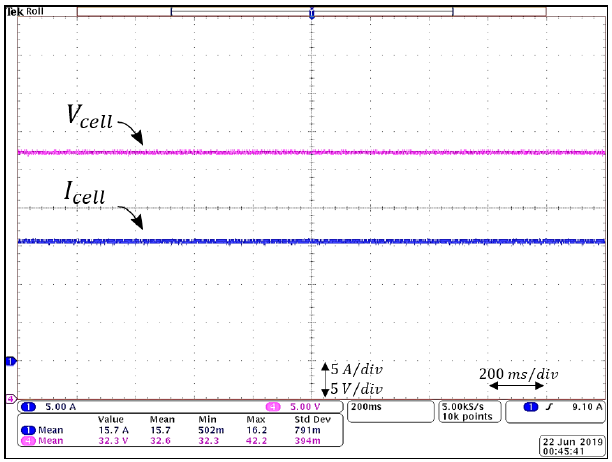
Figure 11. V cell and I cell waveforms corresponding to the C point operating point in Figure 8.